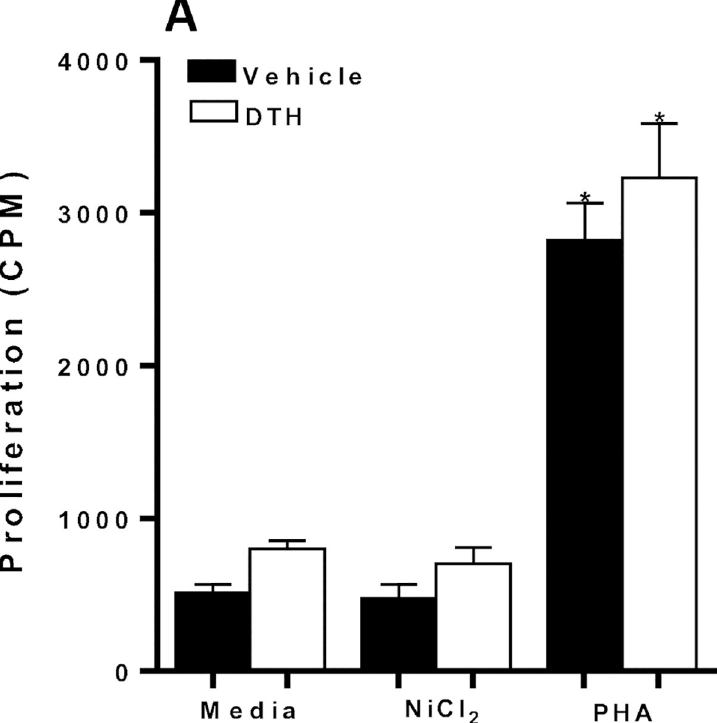
Fig 6. Metal-reactive CD4+ T cells require caspase-1 activity by APCs. At D 14, spleens were harvested from vehicle and metal-sensitized (DTH) C57BL/6 mice. CD4+ T cells were purified from mouse spleens and co-cultured with mitomycin-C treated na ï ve total spleen cells from Caspase-1-/- mice, with Ni (0.001mM) challenge or PHA (non- specific mitogen stimuli) for four days. (A) Proliferation of CD4+ T cells was measured by 3 H-thymidine incorporation. Data represent one of three independent experiments with four mice/group in each experiment. Data are shown as mean ± SEM. Statistical significance was determined by Student’s unpaired two-tailed t-test and asterisk ( � ) denote significant differences P �